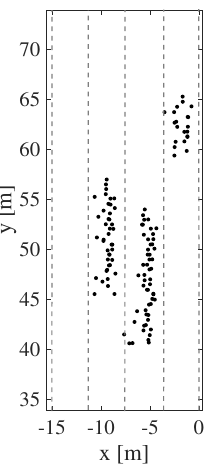
Figure 8. Sampling points of Scene